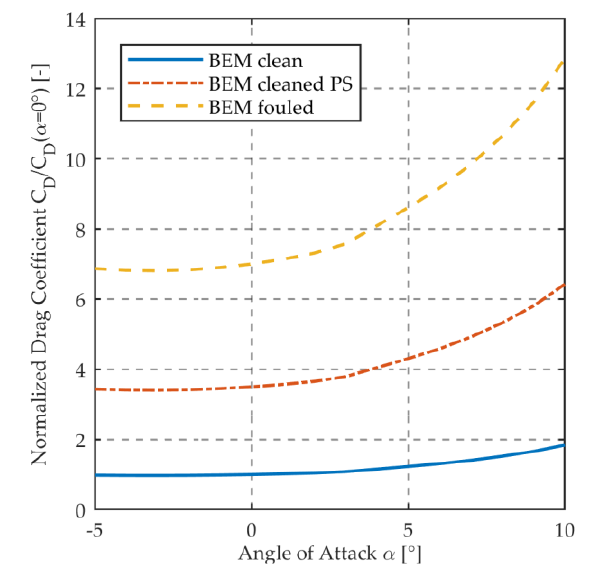
Fig. 9 Variation of the hydrofoil condition (clean, cleaned PS, fouled) and its effect on the normalized drag coefficient as function of the angle of